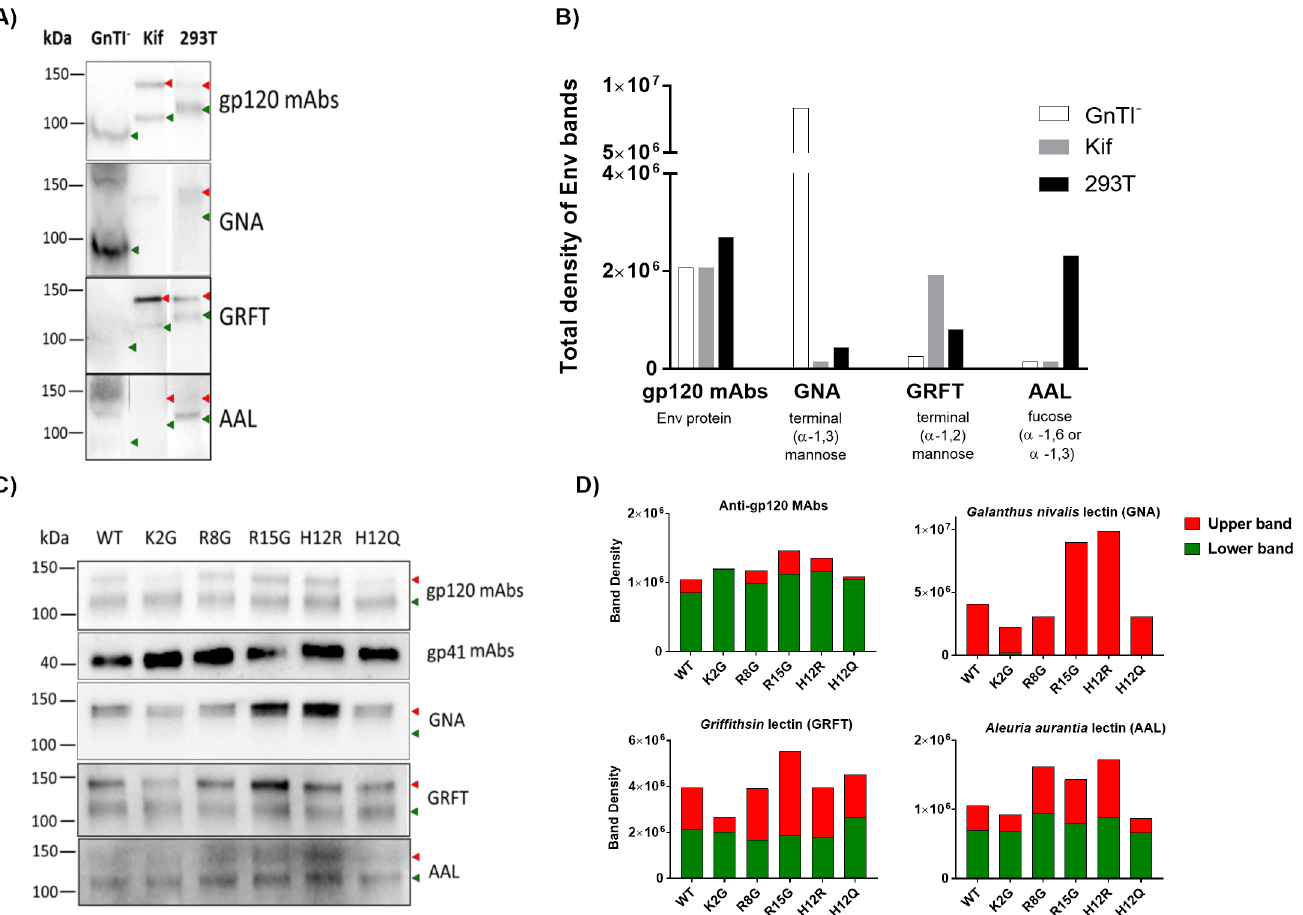
Fig 6. Analysis of REJO Env sugar moieties by lectin-probed Western blotting. The same amounts of Env from sucrose-pelleted virions were separated by SDS-PAGE (4–20%) under reducing conditions, blotted, and probed with an anti-gp120 MAb cocktail, an anti-gp41 MAb cocktail, and lectins (GNA, GRFT, and AAL). A) REJO WT virus produced in GnTI - cells or in 293T cells in the presence vs absence of kifunensine (25 μ M) known to alter Env glycan compositions. B) Quantification of total density of Env bands from REJO WT shown in A). C) REJO WT and mutant viruses produced in 293T cells. D) Density measurements of the upper and lower Env bands as recognized by anti-gp120 MAbs and different lectins. Density analysis was done by Image Lab software. The two Env species with distinct molecular masses are indicated by red and green arrows.